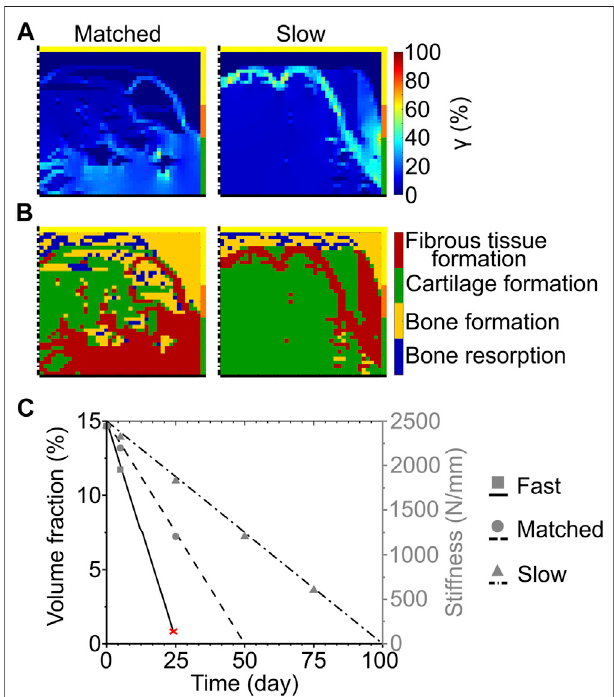
FIGURE 3 | In fl uence of scaffold degradation by surface erosion on osteochondral defect repair. (A) Distribution of octahedral shear strain ( γ ); (B) prediction of tissue formation based on the mechanical stimulus ( S ). The left and right columns show the repair outcome with matched and slow degradation speed at day 125. The yellow, orange, and green borders indicate the neighboring healthy tissues of cancellous bone, subchondral bone, and cartilage, respectively. The dash-dot and solid black lines highlight the axis of symmetry and the articular surface, respectively; (C) Volume fraction (as percentage of the total defect volume) and stiffness of the scaffold during degradation with different speeds. The red cross marks the predicted mechanical failure of the scaffold. Lines and symbols refer to volume fraction and stiffness,